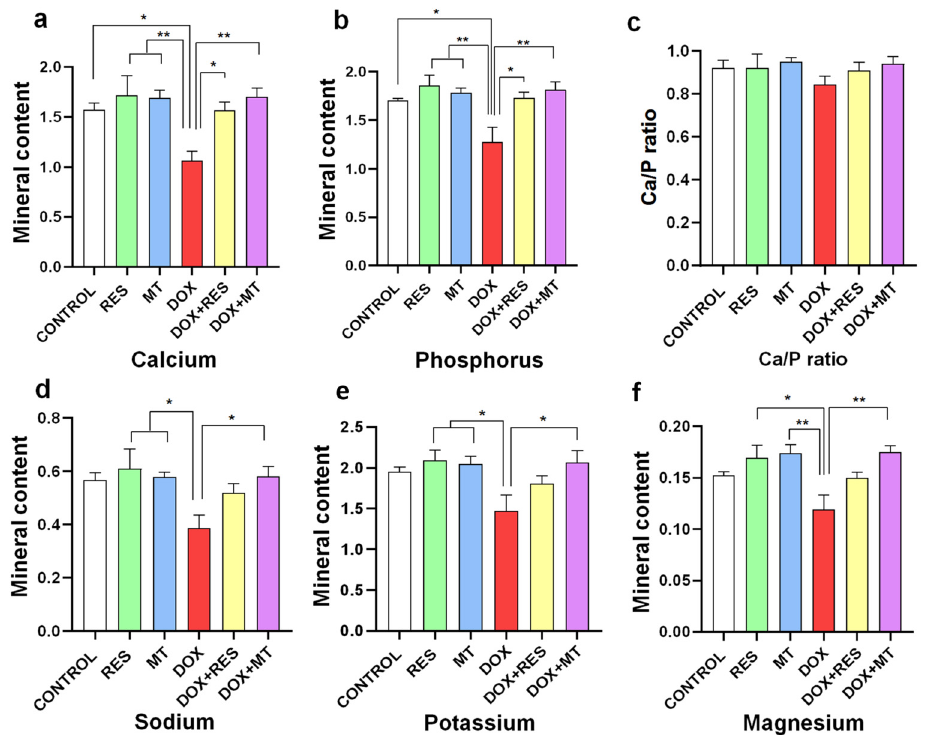
Figure 5. Mineral analysis of zebrafish fed with microdiets supplemented with antioxidants, resveratrol (RES) and MitoTEMPO (MT), and pro-oxidant, doxorubicin (DOX). Mineral content of Calcium ( a ), Phosphorus ( b ), Ca/P ratio ( c ), Sodium ( d ), Potassium ( e ) and Magnesium ( f ). Level of significance was calculated using Tukey’s multiple comparisons (one-way ANOVA) [* p ≤ 0.05 and ** p ≤ 0.01] [N = 8 × 4].